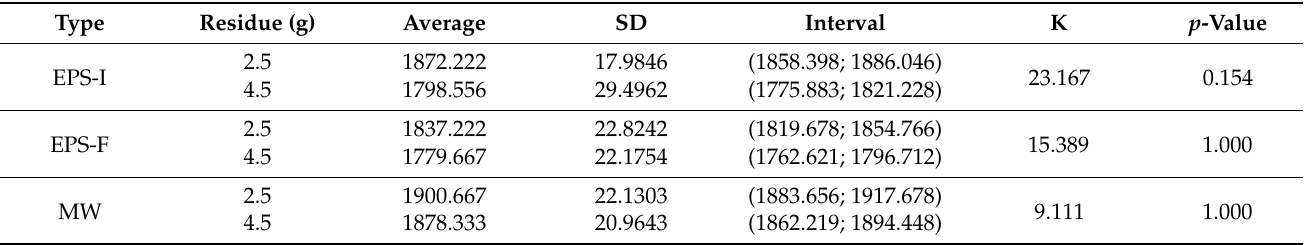
Table 12. Comparison for densities (kg/m 3 ) between mortars with incorporation of